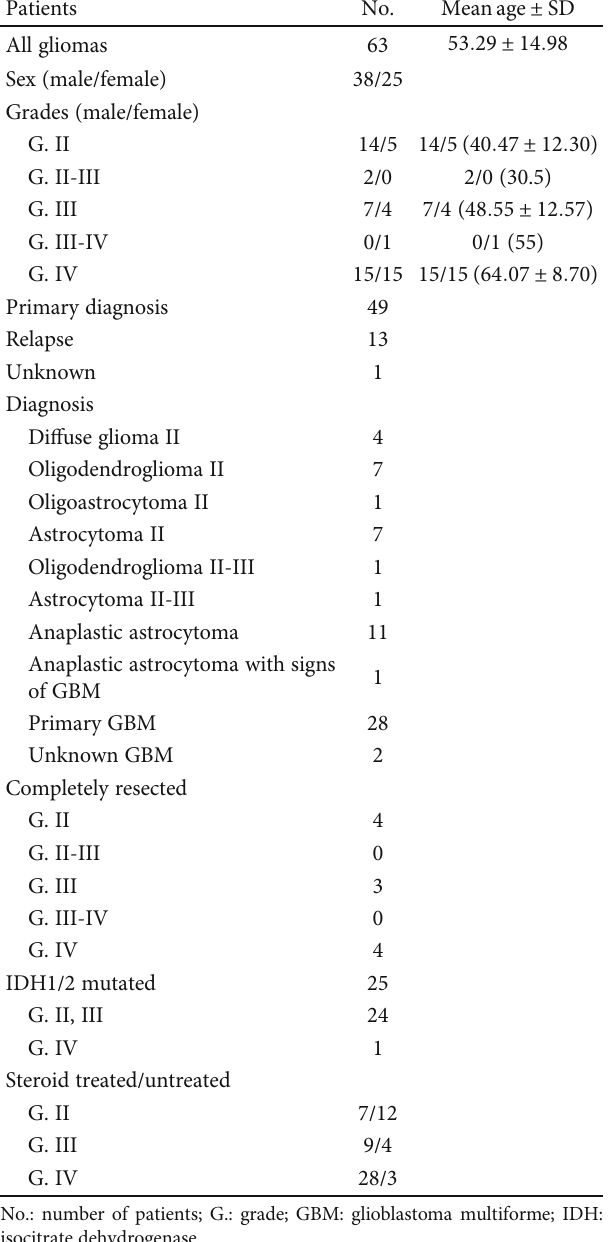
Table 1: Characteristics of glioma